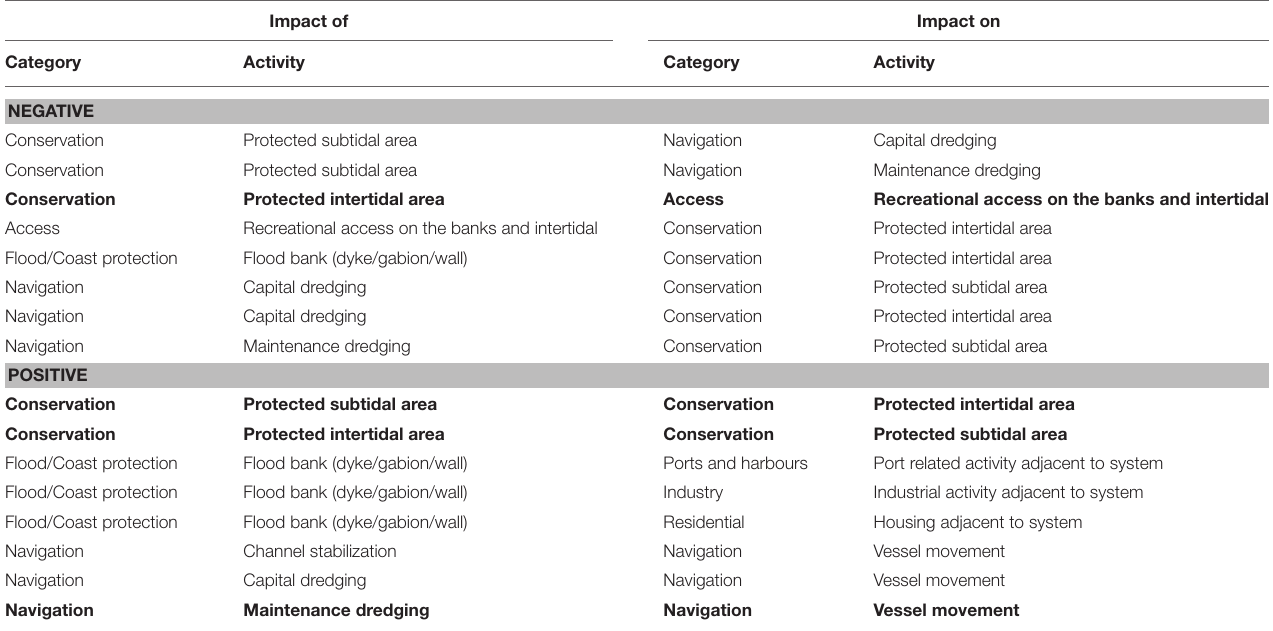
TABLE 6 | Example of results from Conflict Matrix Analysis showing the strong negative and positive associations between uses/users for North Sea